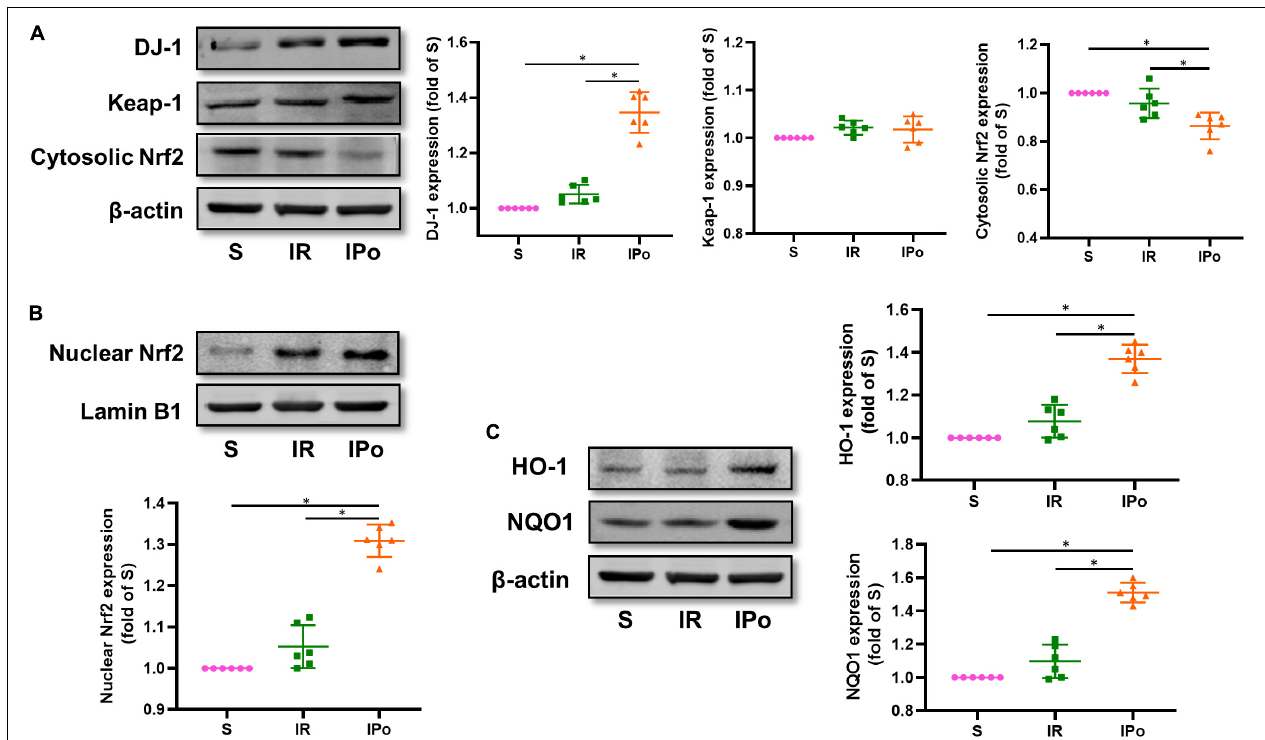
FIGURE 4 | Ischemic postconditioning activates DJ-1, induces Nrf2 nuclear translocation, and upregulates HO-1 and NQO1 expression. (A) Expression of DJ-1, Keap-1, Cytosolic Nrf2. (B) Expression of Nrf2 in the nucleus and (C) of its downstream targets HO-1 and NQO1. Lamin B1 and β -actin were detected as loading controls, respectively, and β -action gel is the same as in Figure 2 . S, Sham; IR, ischemia reperfusion; IPo, ischemic postconditioning. Data are presented as the mean ± SD ( n = 6). * P <